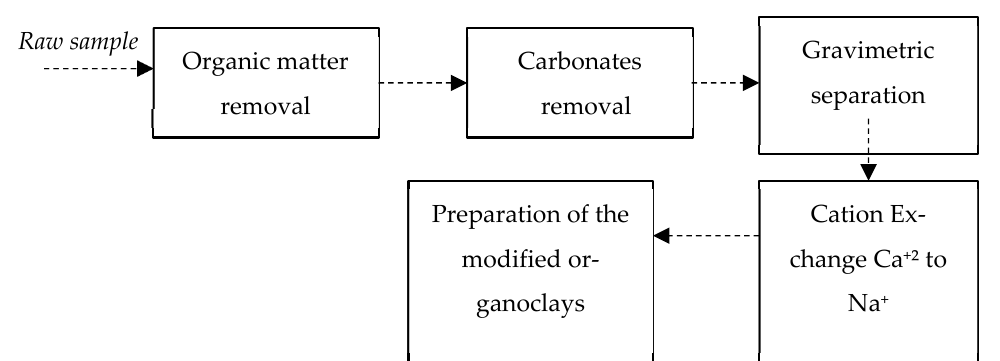
Figure 4. Organoclay preparation scheme.